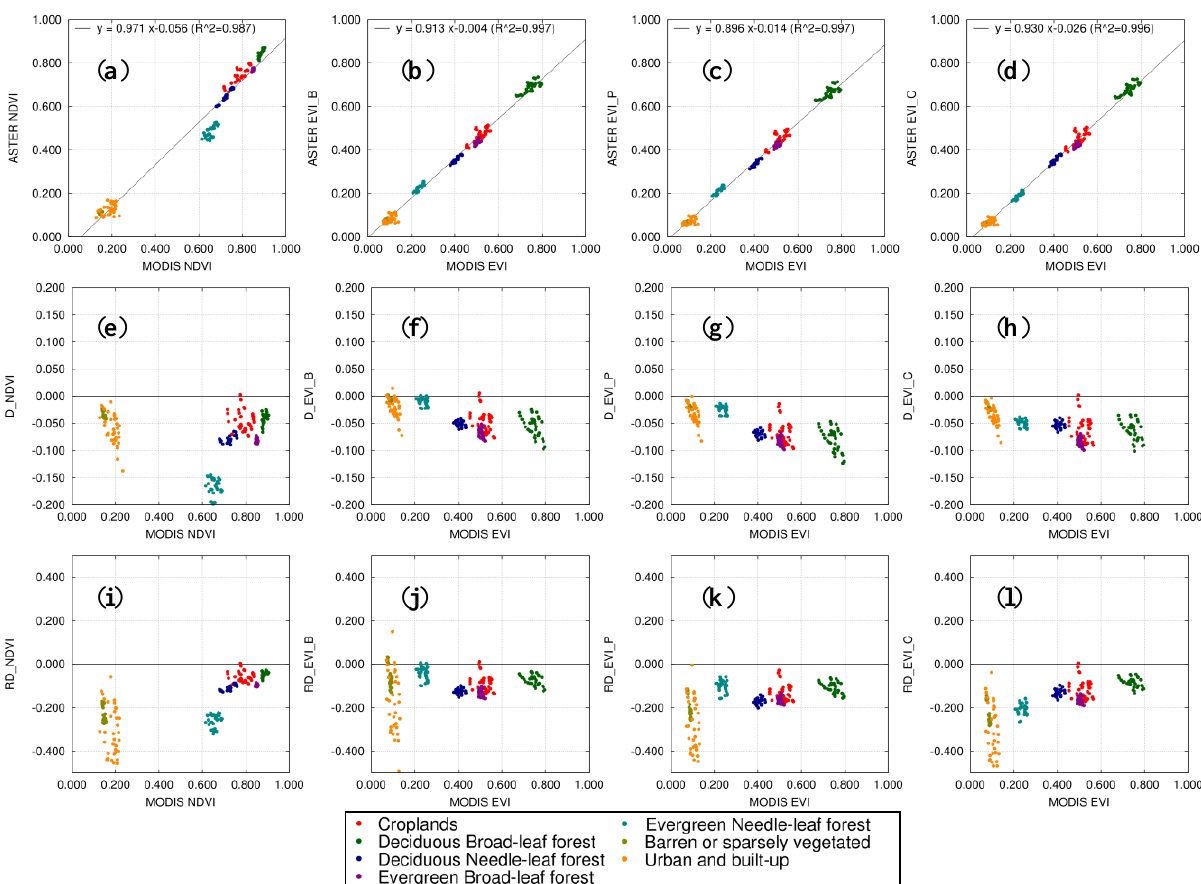
Figure 6 are ASTER NDVI and EVIs aggregated without MODIS PSF (Equation (9)) vs. those aggregated with MODIS PSF (Equation10), and the differences ( and ) and relative errors (